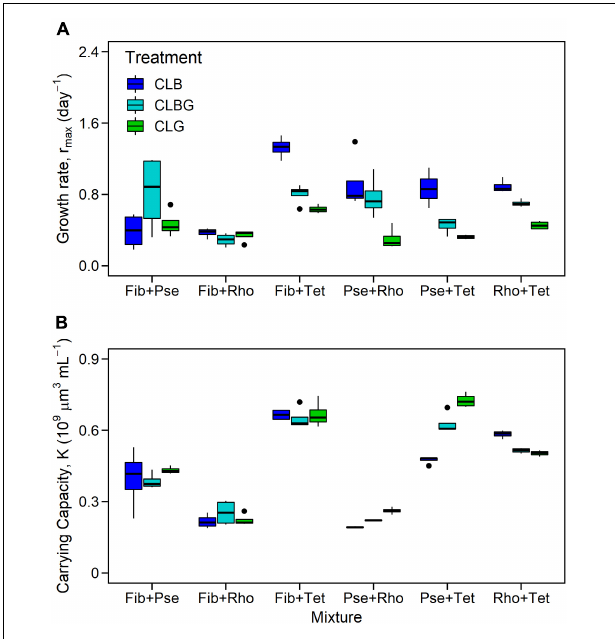
FIGURE 5 | Maximum growth rate (A) and carrying capacity (B) for two-species mixtures. Colors indicate constant light treatments (CLB, constant blue light; CLBG, constant blue-green light; CLG, constant green light).